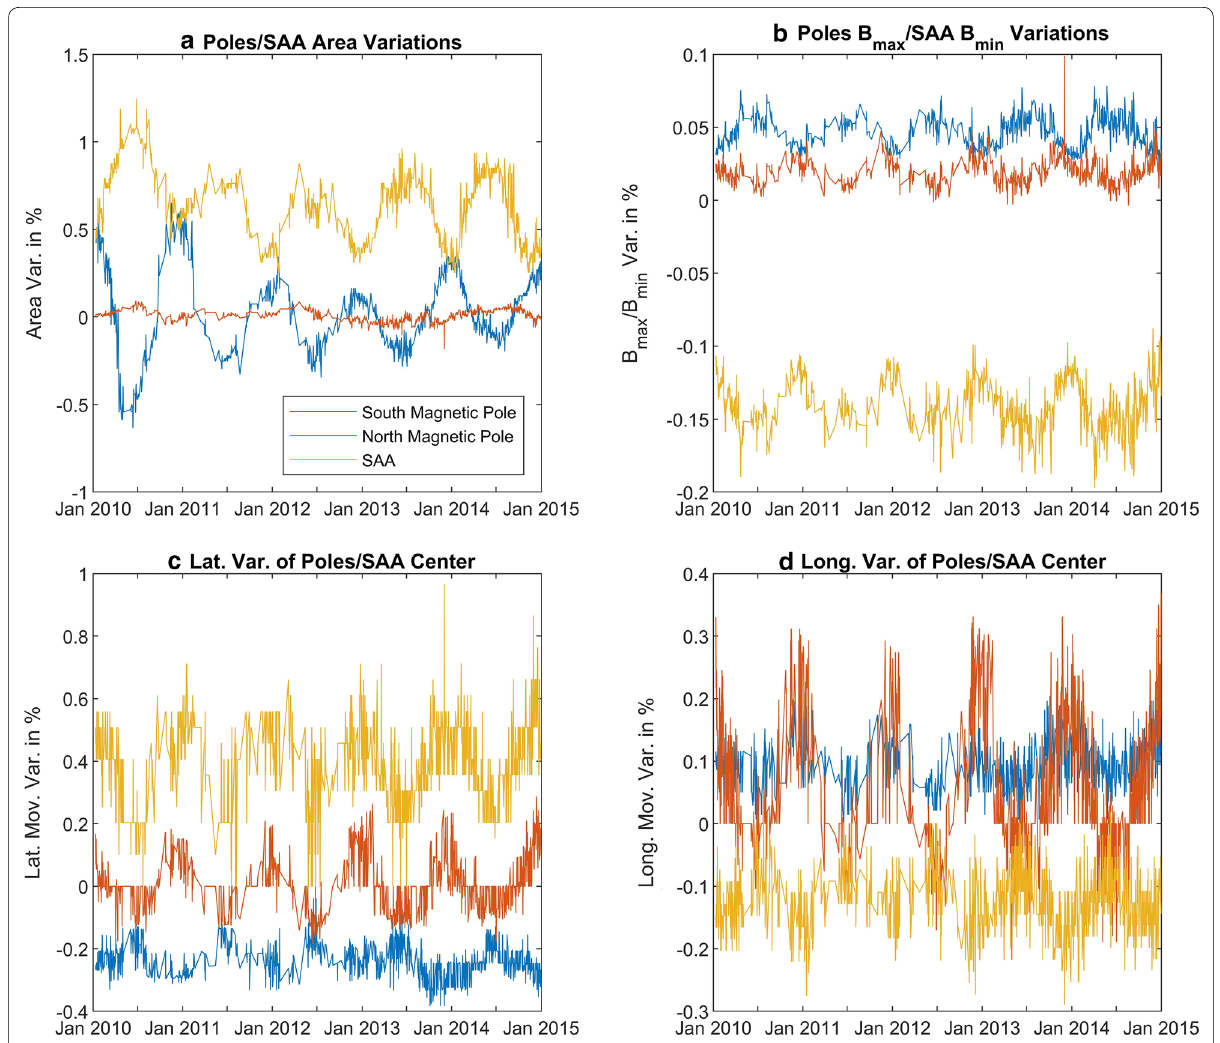
Fig. 6 Magnetic poles temporal variations. Magnetic poles and the SAA variation profiles for the four variables: the area, the minimum/maximum magnetic field intensity, the latitudinal and longitudinal center movements at 1000 km